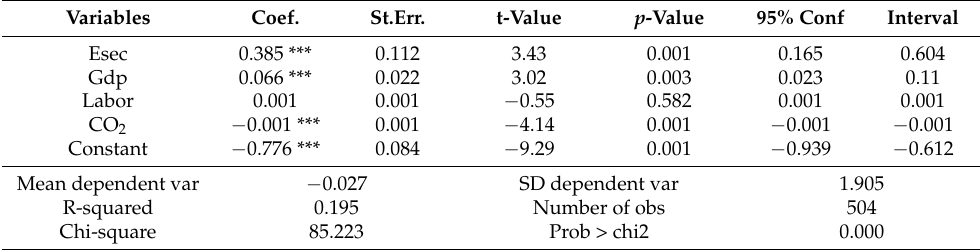
Table 6. Instrumental variables (GMM) regression.